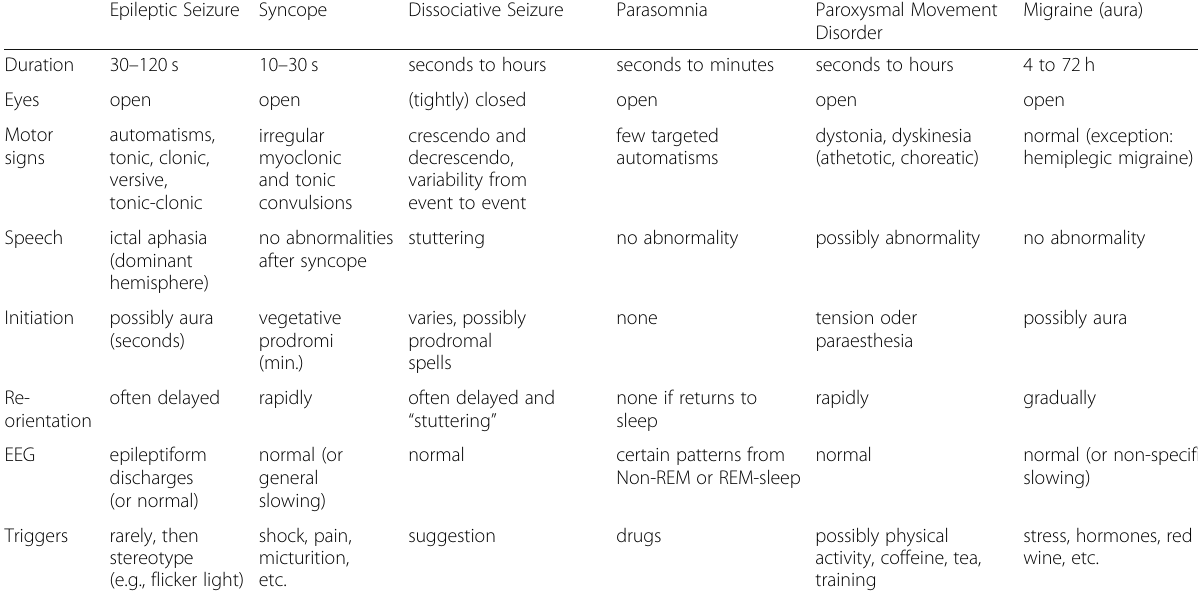
Table 1 Selected differential diagnoses (modified from [12]) Epileptic Seizure